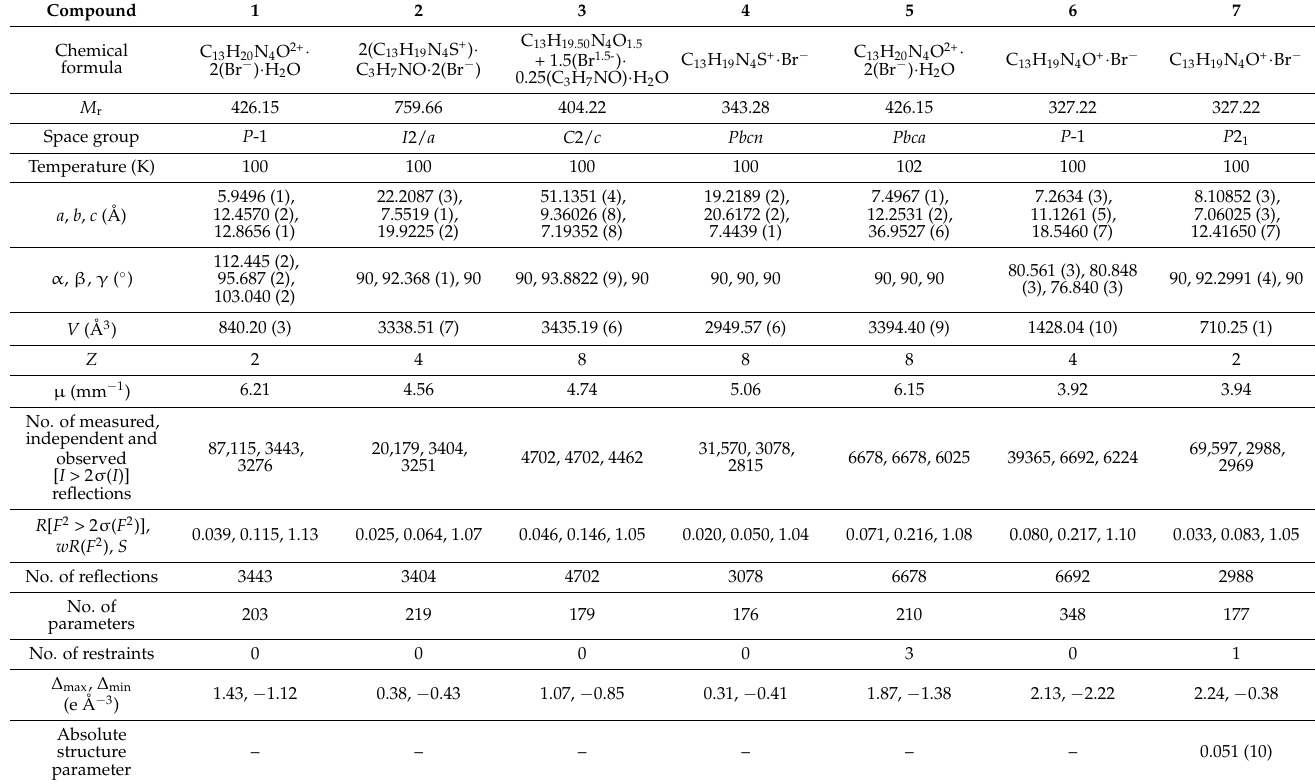
Table 1. Crystal data, data collection and refinement